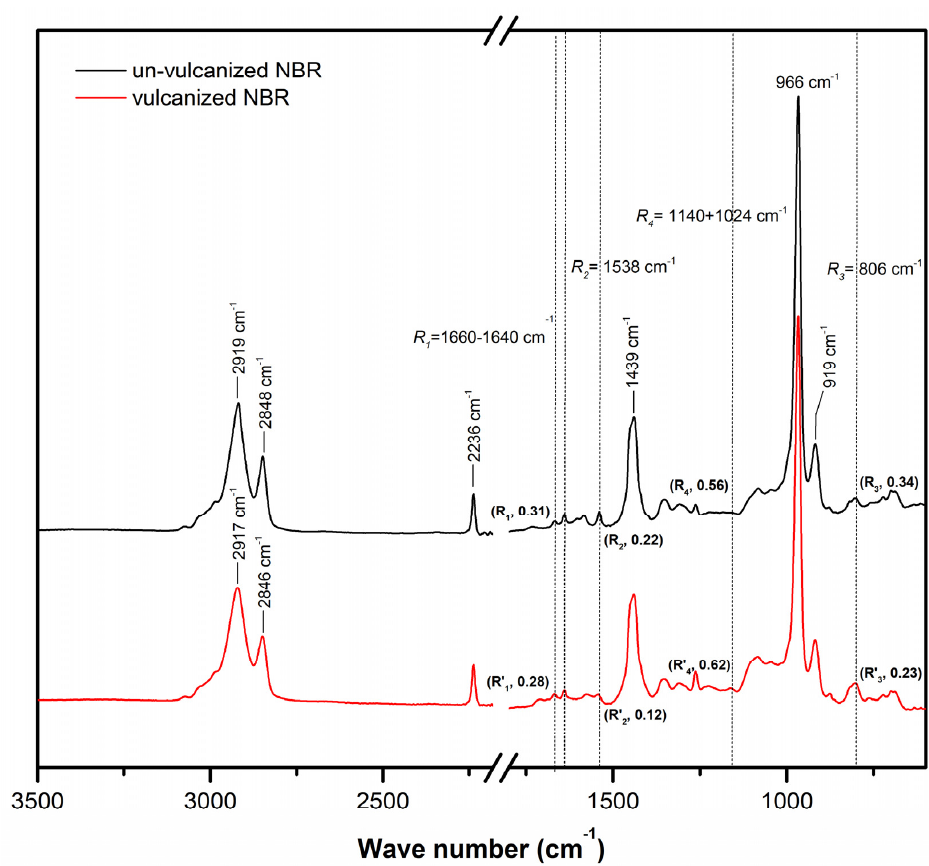
Figure 5. Representative ATR-FTIR spectra of the unvulcanized and peroxide-vulcanized NBR. The ATR-FTIR spectra of NBR vulcanizates with varying SBOFA loadings is shown in Figure 6. All the NBR vulcanizates with SBOFA showed an absorption peak at 1740 cm − 1 (C=O stretching of the sodium salt fatty acids) [25,31], which was absent in the NBR vulcanizate without SBOFA. Hence, this peak indicated the presence the SBOFA. In addi- tion, the intensity ratio of the peak at 1740 cm − 1 to the reference peak at 1443 cm − 1 increased groups with increasing SBOFA loading (Figure 6 and Table 4). In addition, new peaks at 1538 cm − 1 and 1578 cm − 1 appeared in all NBR vulcanizates with SBOFA after vulcaniza- tion, which were attributed to the asymmetric and symmetric coupled C–O stretching of